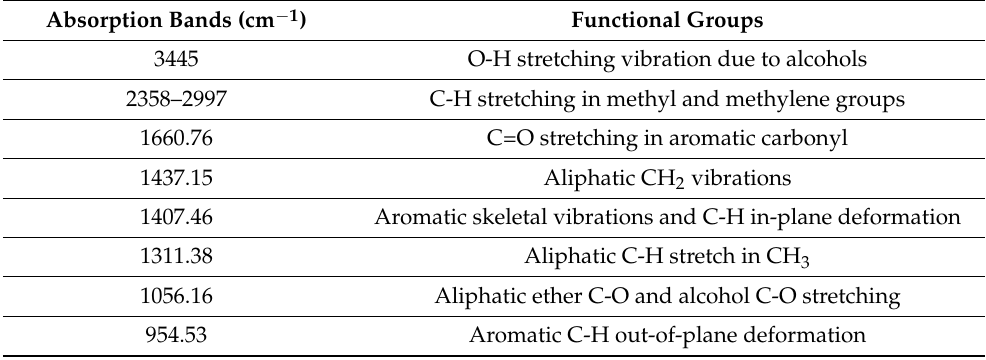
Figure 3. FTIR spectrum of extracted lignin from the pistachio shell and pine sawdust biomass and compared with commercial lignin. Table 1. Functional group assignment of FTIR analysis of extracted lignin from pine sawdust and pistachio shells.